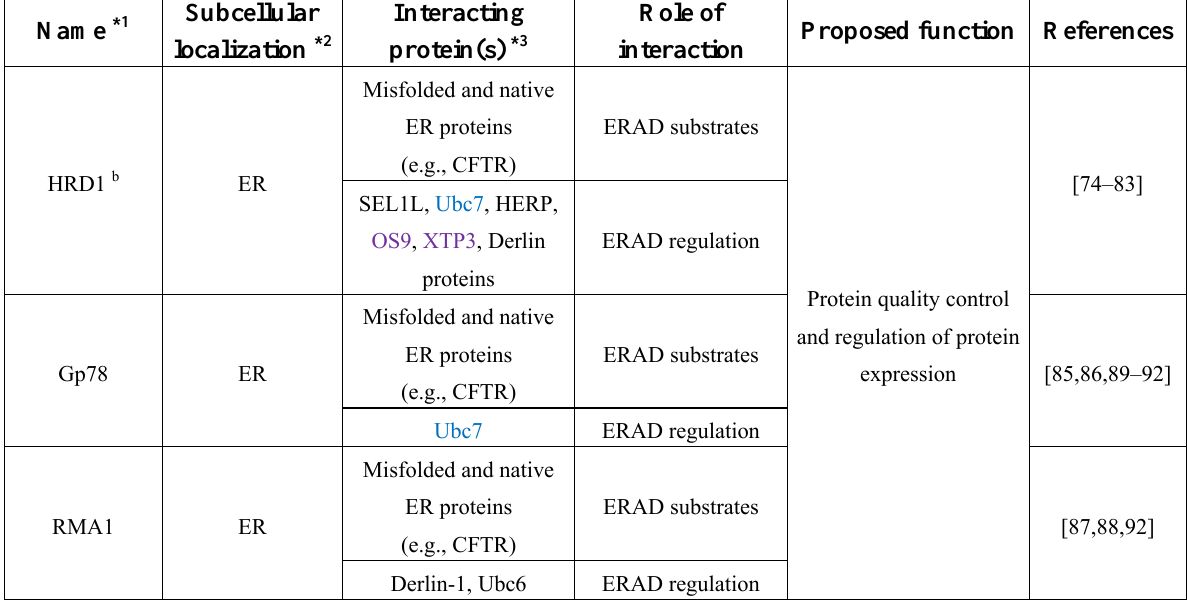
Table 1. Summary of known properties of transmembrane RNF